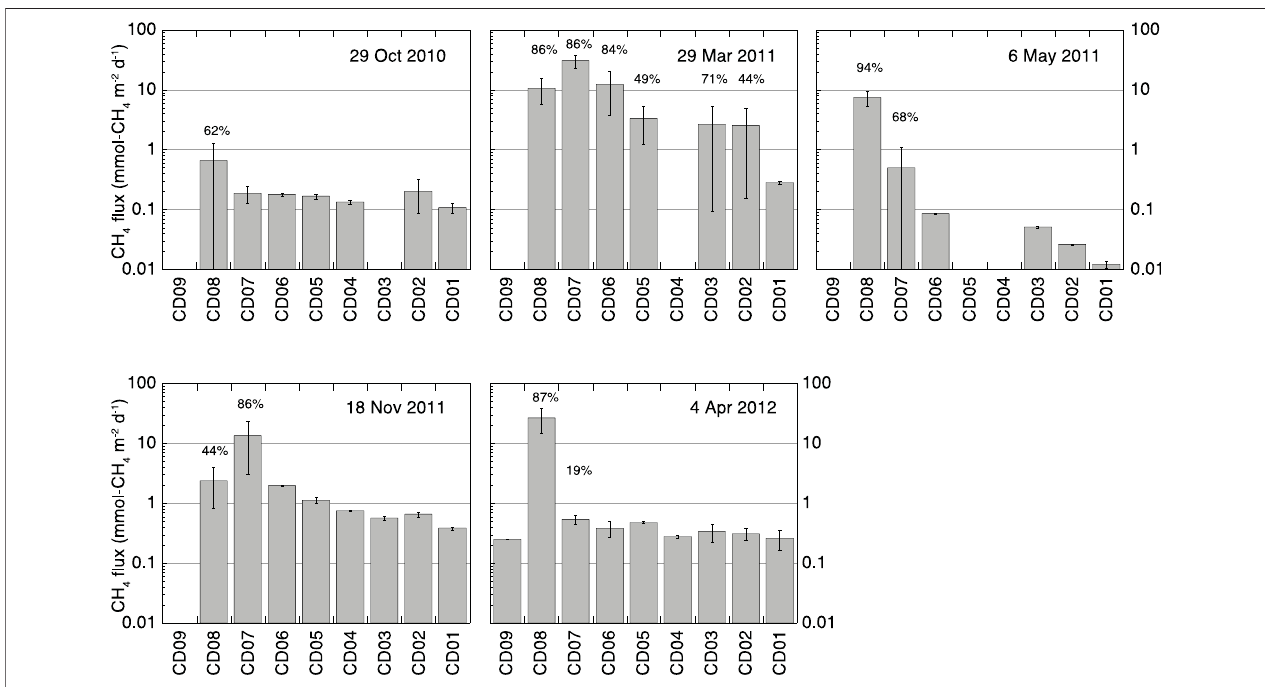
FIGURE 4 | Average 15-min methane fl uxes (mmol-CH 4 m − 2 d − 1 ) measured at each site during the fi ve fi eld trips: 29 October 2010. 29 March 2011, 6 May 2011, 18 November 2011, 4 April 2012. Missing bars indicate no measurement performed. Percentages above bars are the fraction of the measured fl uxes attributable to ebullition. Error bars denote one sample standard deviation.